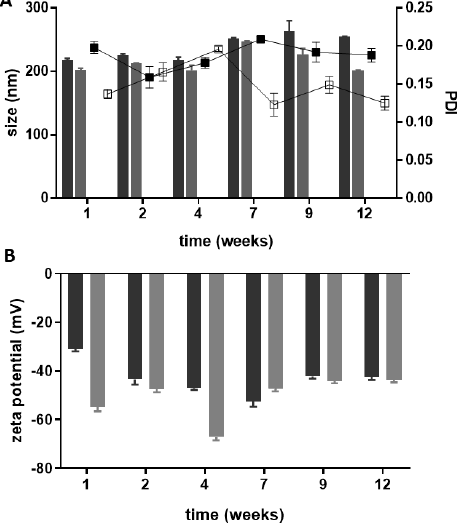
Figure 3. Physicochemical stability over 12 weeks at room temperature. Particle size and the PDI ( A ) and the zeta-potential ( B ) of the SLNs (dark grey) and NLCs (light grey) suspensions. In the A graphic, bars represent the size (left Y axis) and dots represent the PDI (right Y axis). Values represent the mean ± SD of three independently synthetized formulations.